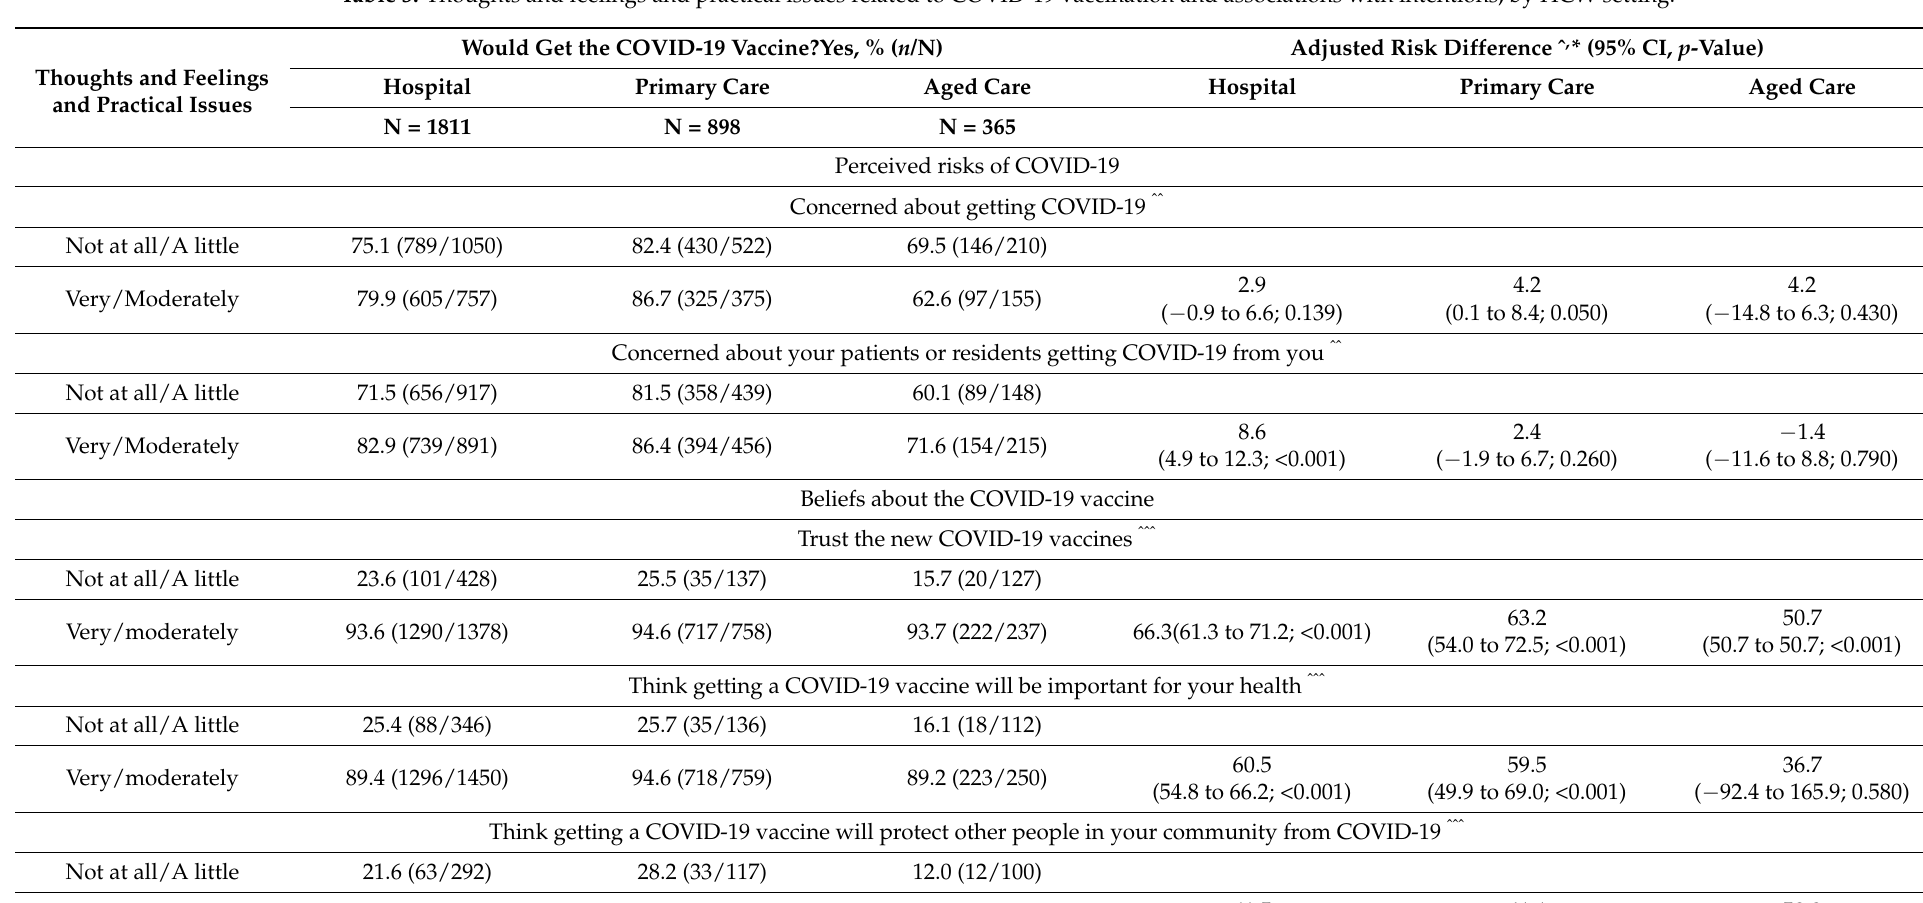
Table 3. Thoughts and feelings and practical issues related to COVID-19 vaccination and associations with intentions, by HCW